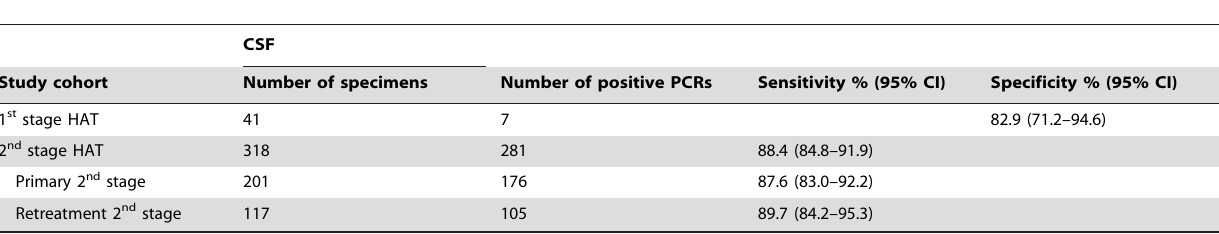
Table 2. Sensitivity and specificity of PCR on CSF for staging of